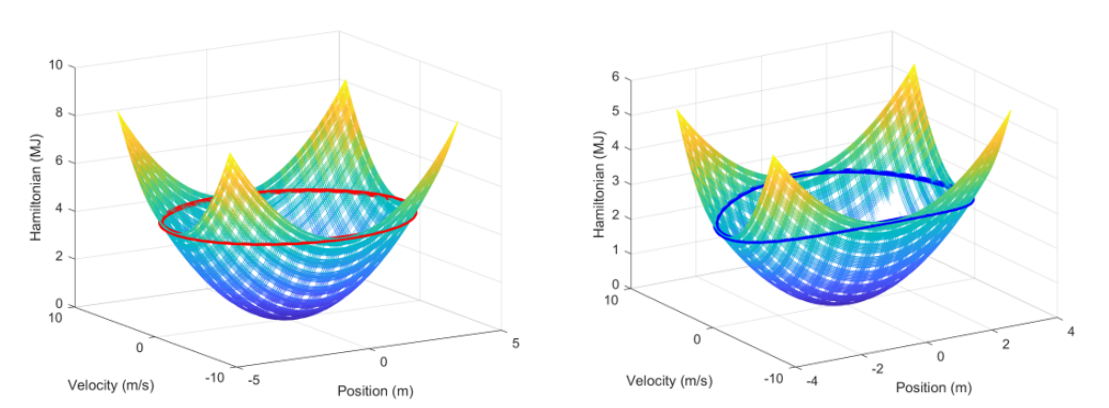
Figure 4. For a single frequency the resonance ω = Ω , ( left ) and off-resonance ω (cid:54) = Ω , ( right )